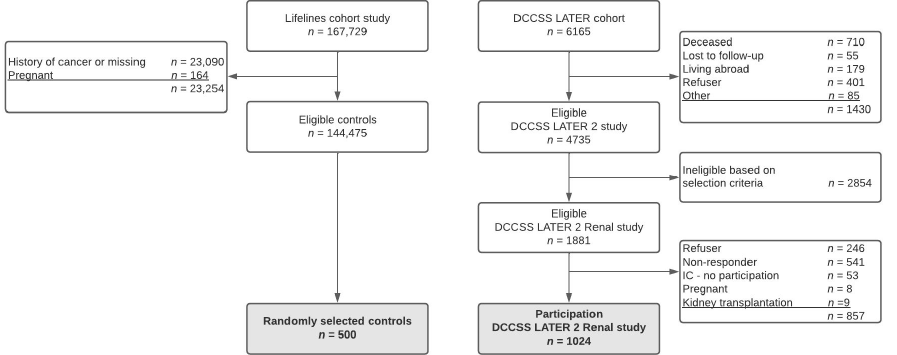
Figure 1. Flowchart study cohort. Abbreviations: DCCSS, Dutch Childhood Cancer Survivor Study; IC, informed consent. Table 2. Baseline characteristics study cohort.